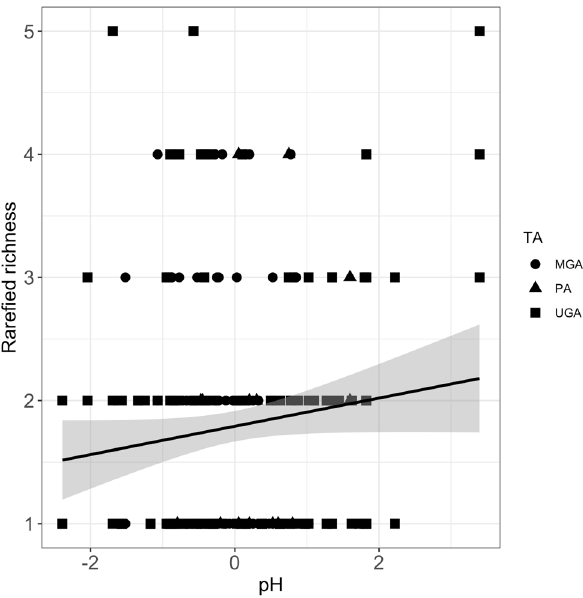
Figure 4. Linear regression between species richness, grouped by management scenarios (MS): protected areas (PA), managed green areas and (MGA) and unmanaged green areas (UGA), and pH standardised to have mean zero and unit variance. The shaded area represents the confidence